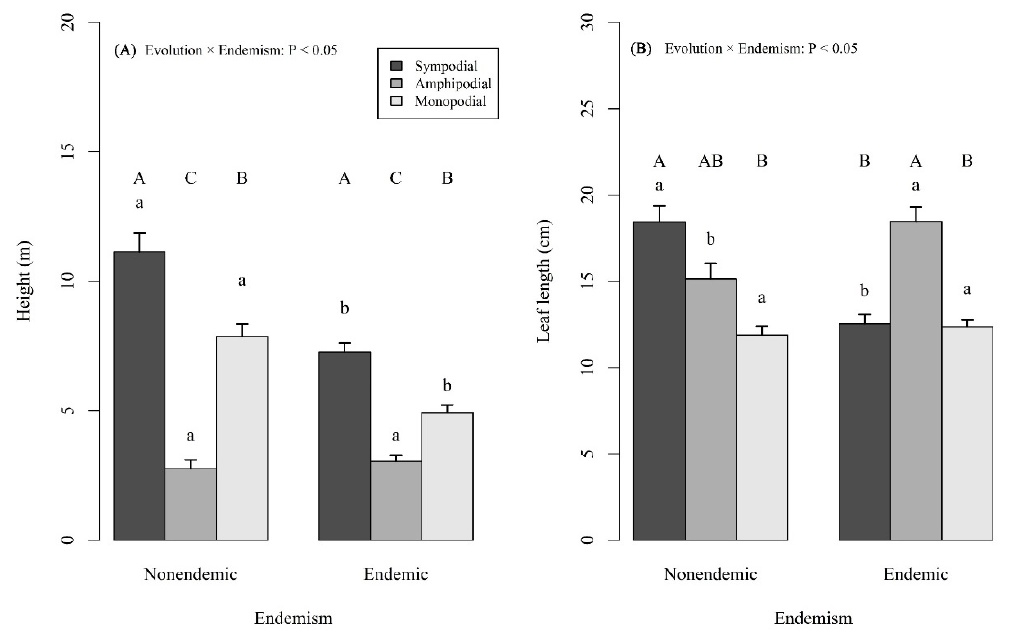
Figure 4. Effect of endemism on traits of different rhizome types. Boxes with different letters differ significantly at p < 0.05. The lowercase letters mean the difference between different endemism types. The uppercase letters mean the differences among different rhizome types. “ × ” means the interaction between two factors.